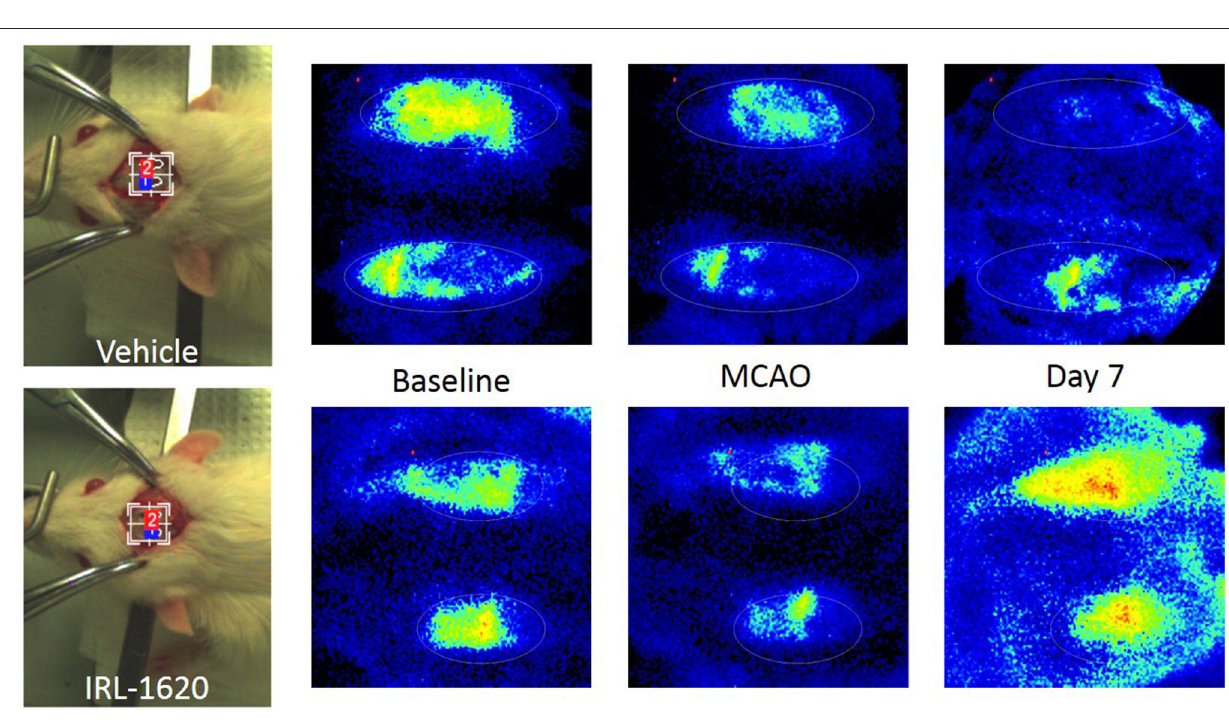
activation may be an innovative neuroprotective therapy for